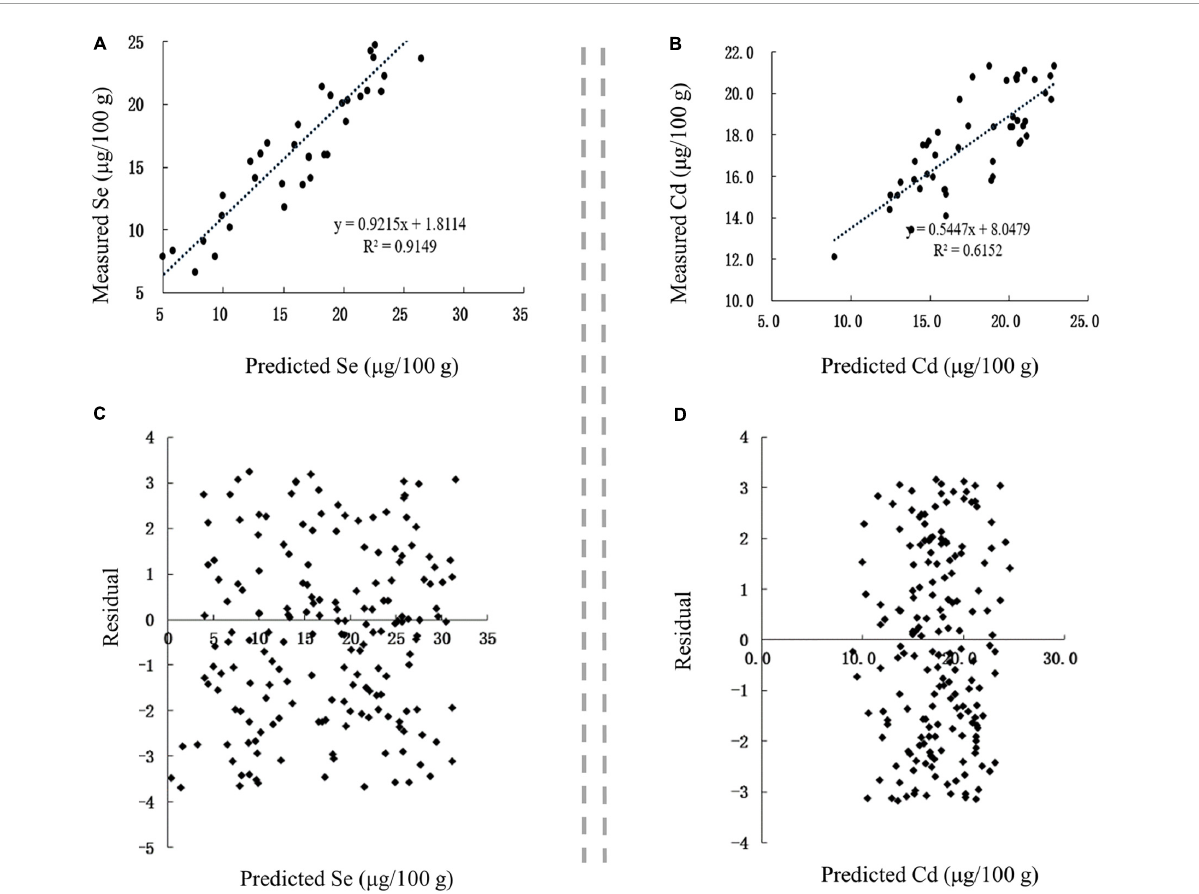
FIGURE8 Validation of prediction models in Se-rich garlic. (A,B) Correlation between the predicted and measured Se and Cd contents, respectively. (C,D) Residual analysis of the fitted and measured Se and Cd contents,